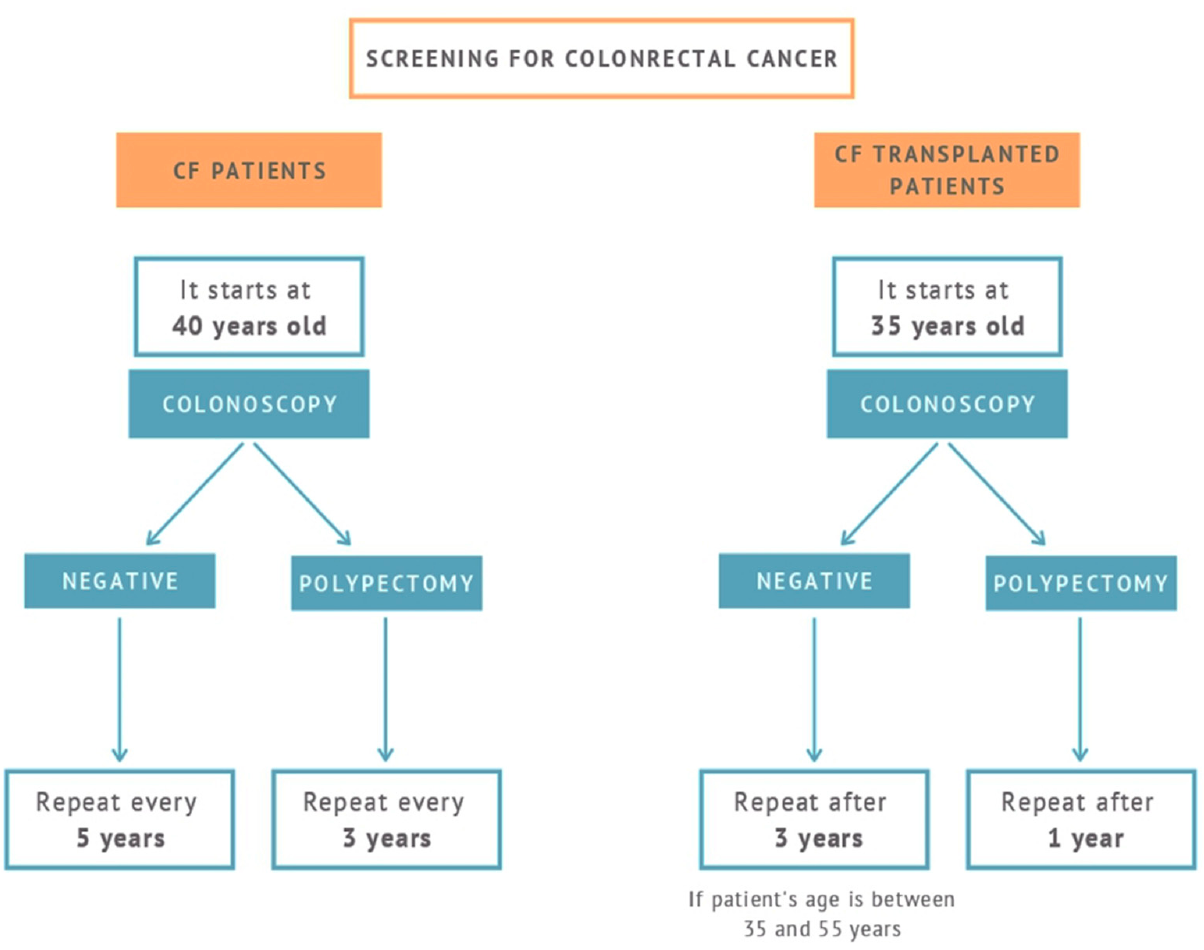
Figure 2. Screening for CRC in CF patients.